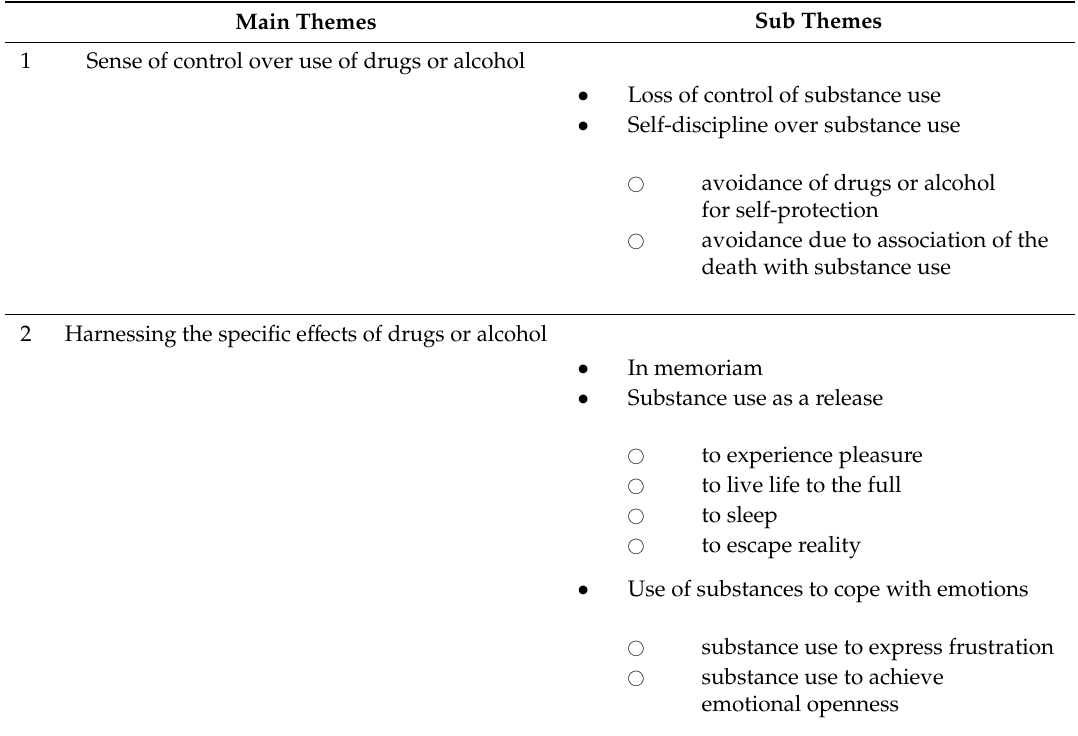
Table 2. Table describing themes and